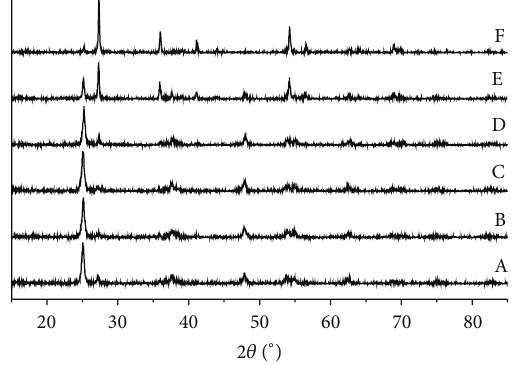
Figure 1: XRD spectra for samples with different calcination temperatures. A: P25, B, C, D, E, and F were Mo-P25 prepared at calcination temperature of 300 ∘ C, 400 ∘ C, 500 ∘ C, 600 ∘ C, and 700 ∘ C,